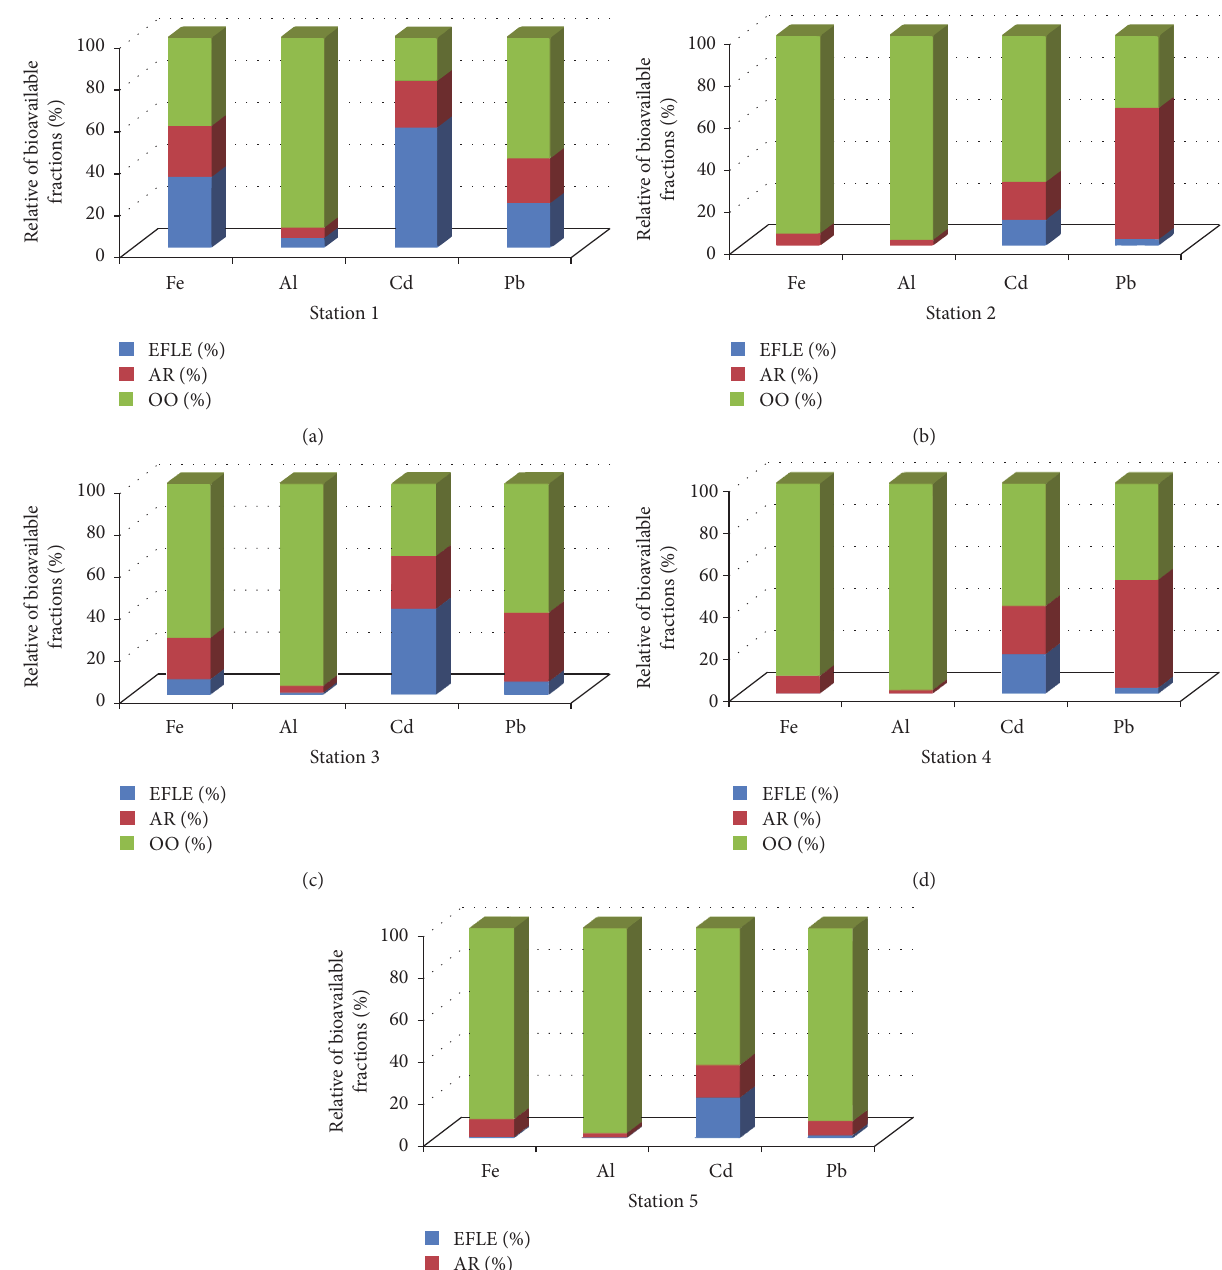
Figure 1: Percentage of heavy metal concentrations in the labile fractions (EFLE, AR, and OO) in sediments.